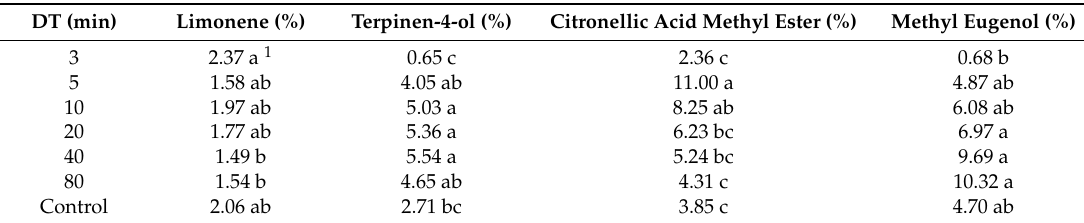
Table 7. Mean Juniperus sabina concentration (%) of limonene, terpinen-4-ol, citronellic acid methyl ester, and methyl eugenol in the essential oil fractions obtained from the seven distillation timeframes (DT).